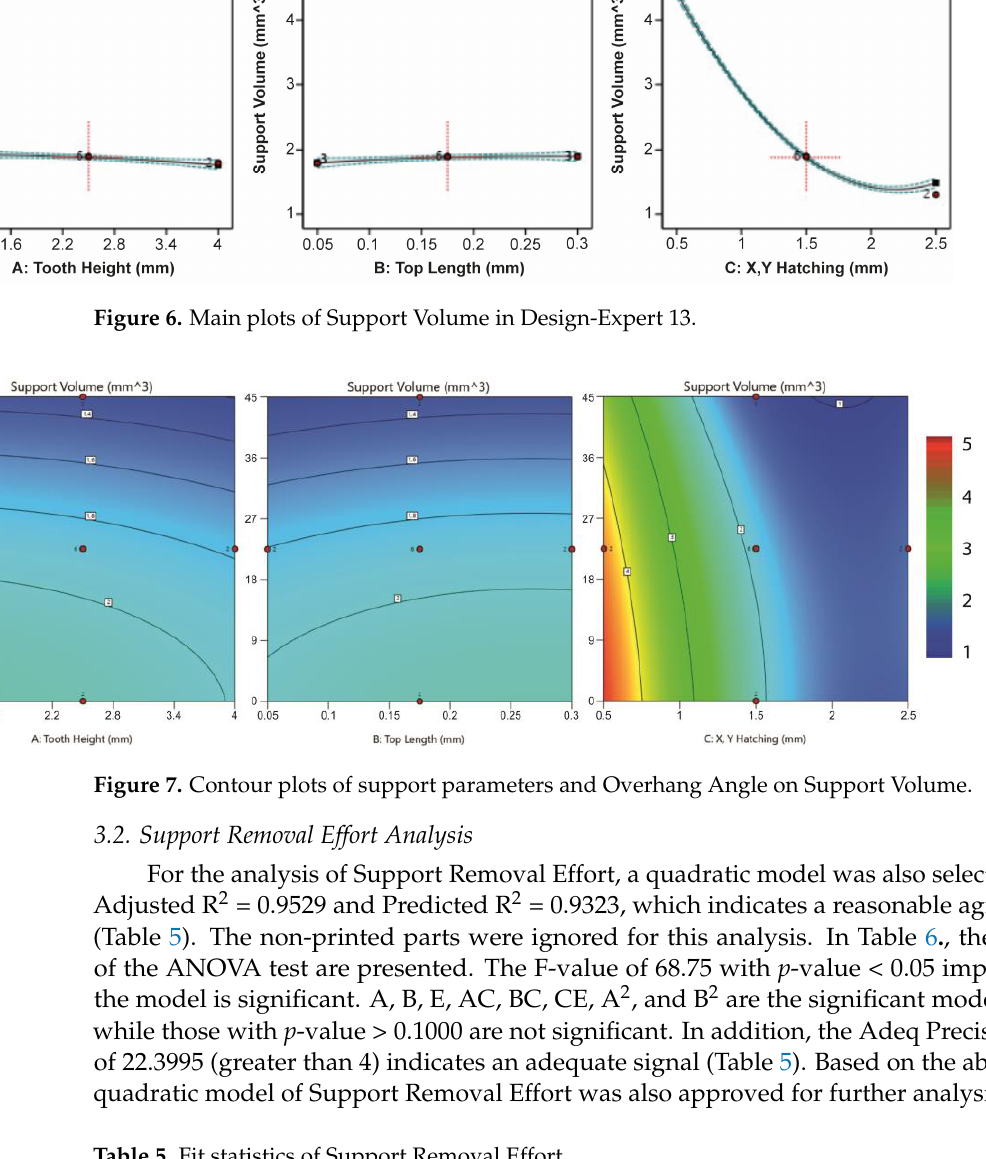
Table 5. Fit statistics of Support Removal